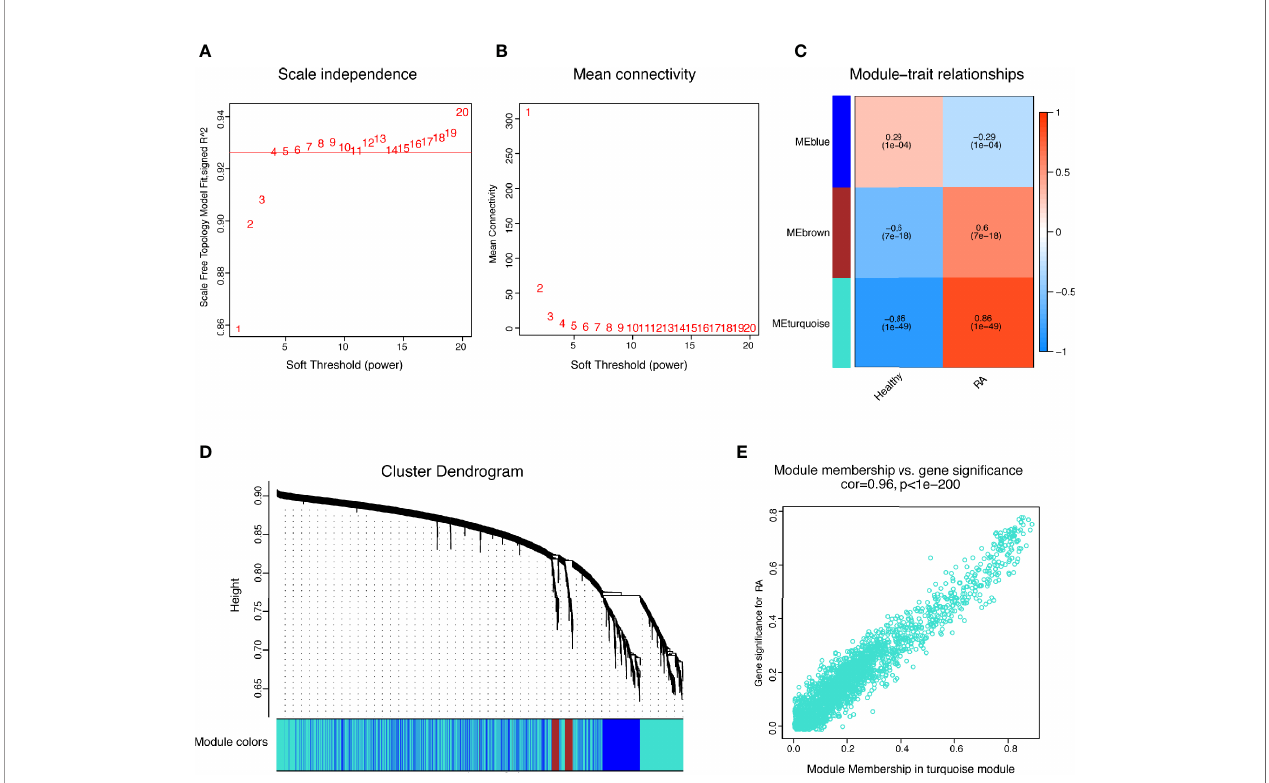
FIGURE 5 | WGCNA revealed gene co-expression networks in the whole peripheral blood of 169 RA patients. (A, B) Analysis of the scale-free fi t index and the mean connectivity for various soft-thresholding powers; (C) Relationships of consensus modules with samples. It contains a set of highly linked genes. Each speci fi ed color represents a speci fi c gene module; (D) Clustering dendrogram of differentially expressed genes related to RA; (E) The gene signi fi cance for RA in the turquoise module (one dot represents one gene in the turquoise